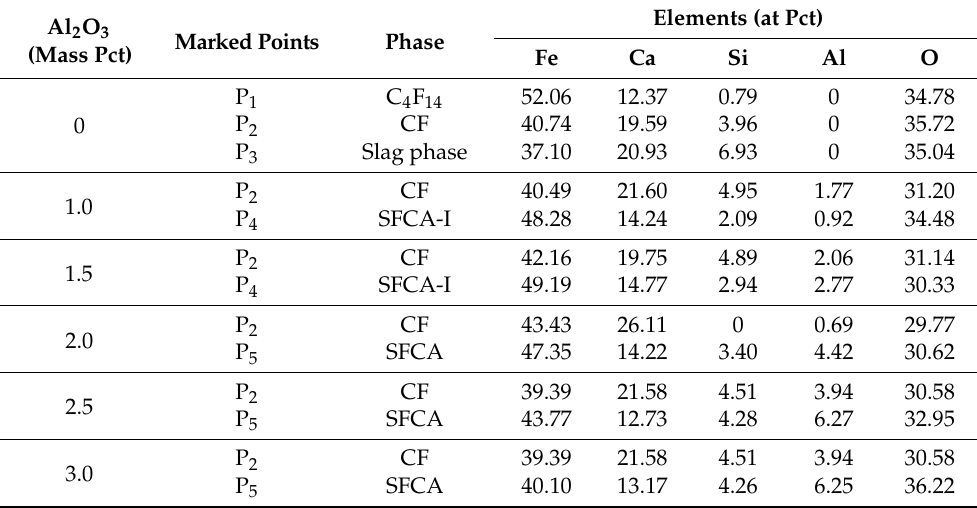
Figure 12. SEM image of the cross-section of the sample after cooling at 5 °C/s. Table 5. The EDS results of the corresponding marked points in Figure 12.